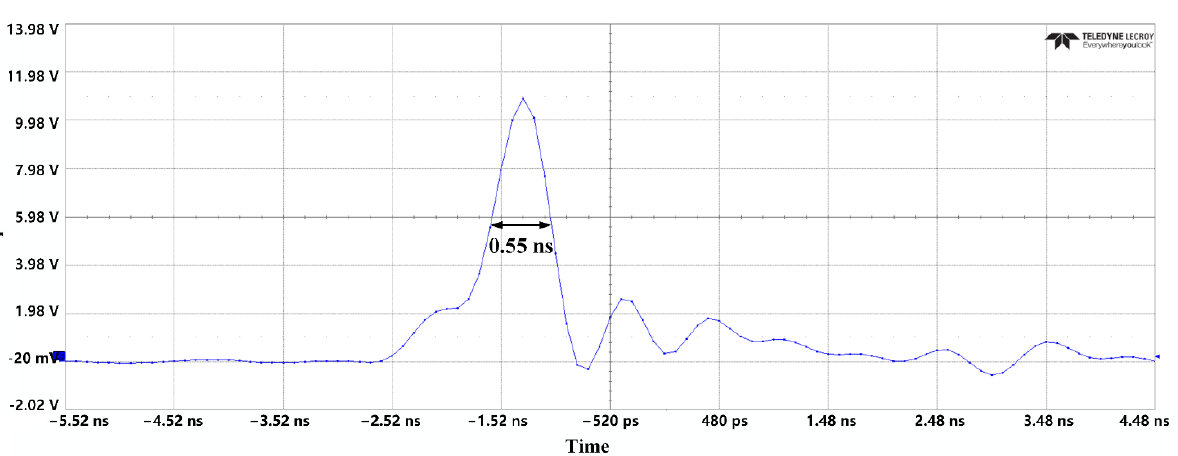
( b ) Figure 13. LNA sample: ( a ) photo; ( b ) circuit schematic. The injection experiment is carried out at a room temperature of 27 °C. To prevent the equipment from being damaged by UWB EMP, it is necessary to connect attenuators to the output port of the UWB EMP source. Then, the UWB EMP and BDS-III carrier signal are simultaneously injected into the LNA, as shown in Figure 14.